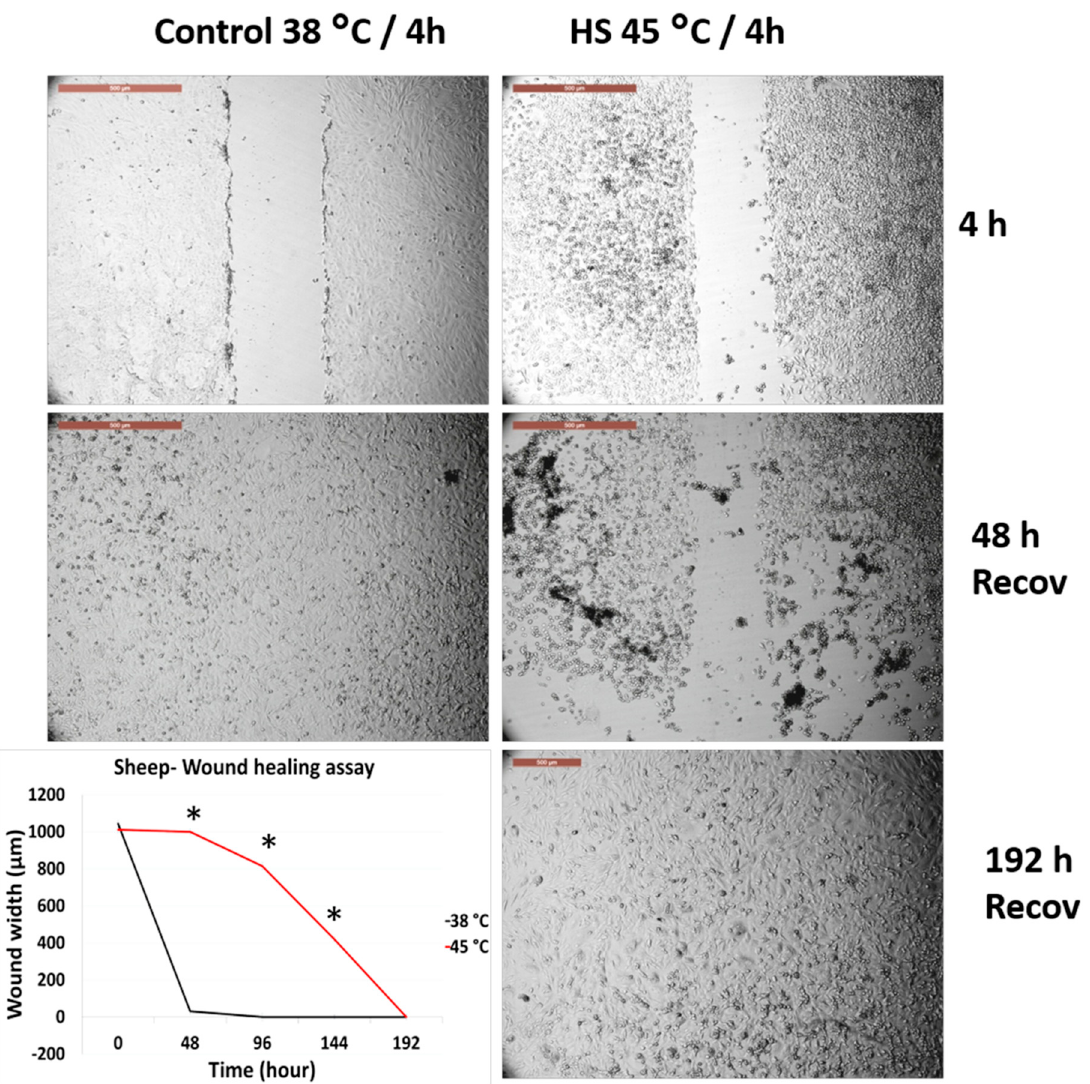
Figure 3. Wound healing (cell scratch) assay for sheep primary cultured fibroblasts exposed to 45 °C for 4 h and control cells (38 °C for 4 h). Cells were incubated under the required conditions, recovered at 38 °C, and monitored daily for wound closure. Scale bar = 500 µm. Data are presented as means ± SEM, values of the same timings were analyzed using Student’s t -test, and asterisks (*) indicate significant differences at p < 0.05.